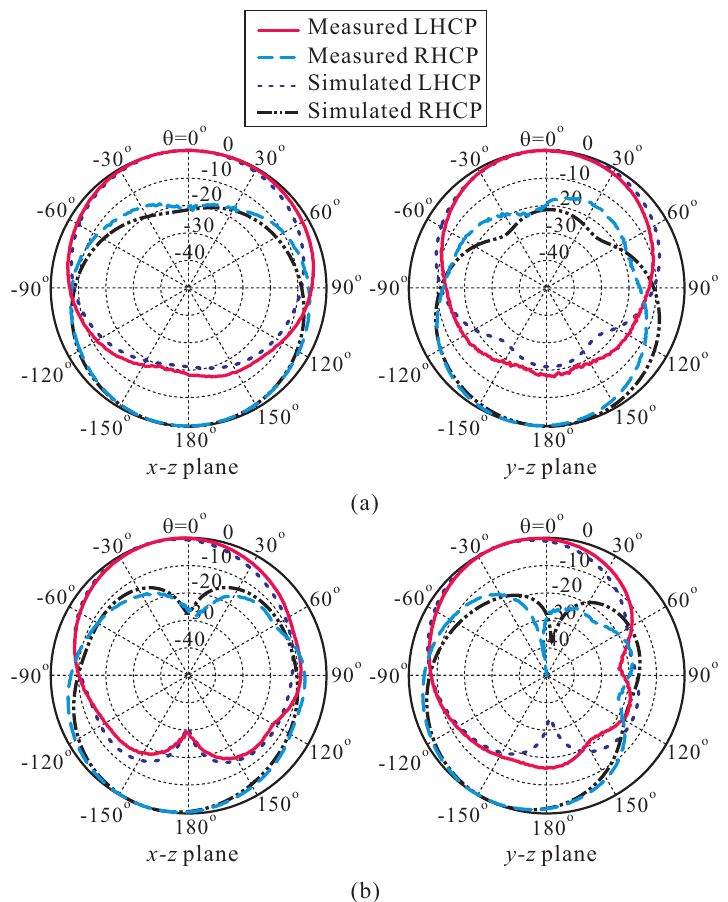
Figure 9. Simulated and measured normalized radiation patterns of the proposed antenna: ( a ) 2.1 GHz; ( b ) 3.7